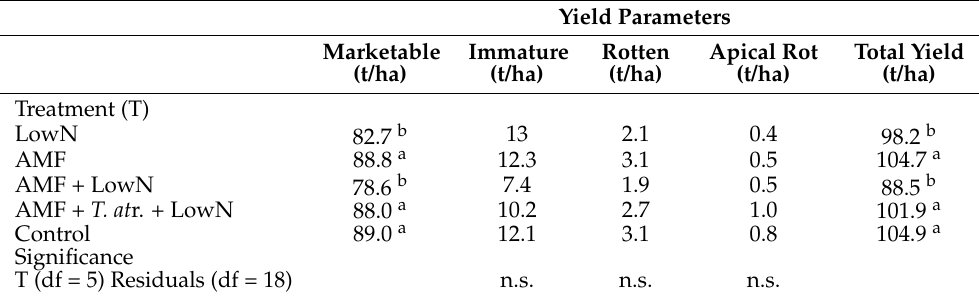
Table 2. Yield parameters for tomato grown under low nitrogen fertilization regimen, treated with different biostimulants at the site with optimal soil fertility. The data were elaborated by one-way analysis and Duncan